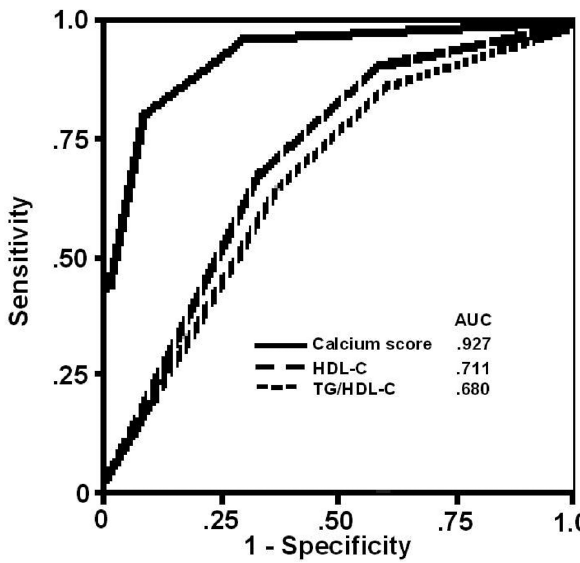
Figure 2 - ROC curves by quartiles of Agatston, TG/HDL-c and HDL-c for patients with a Friesinger index ≥